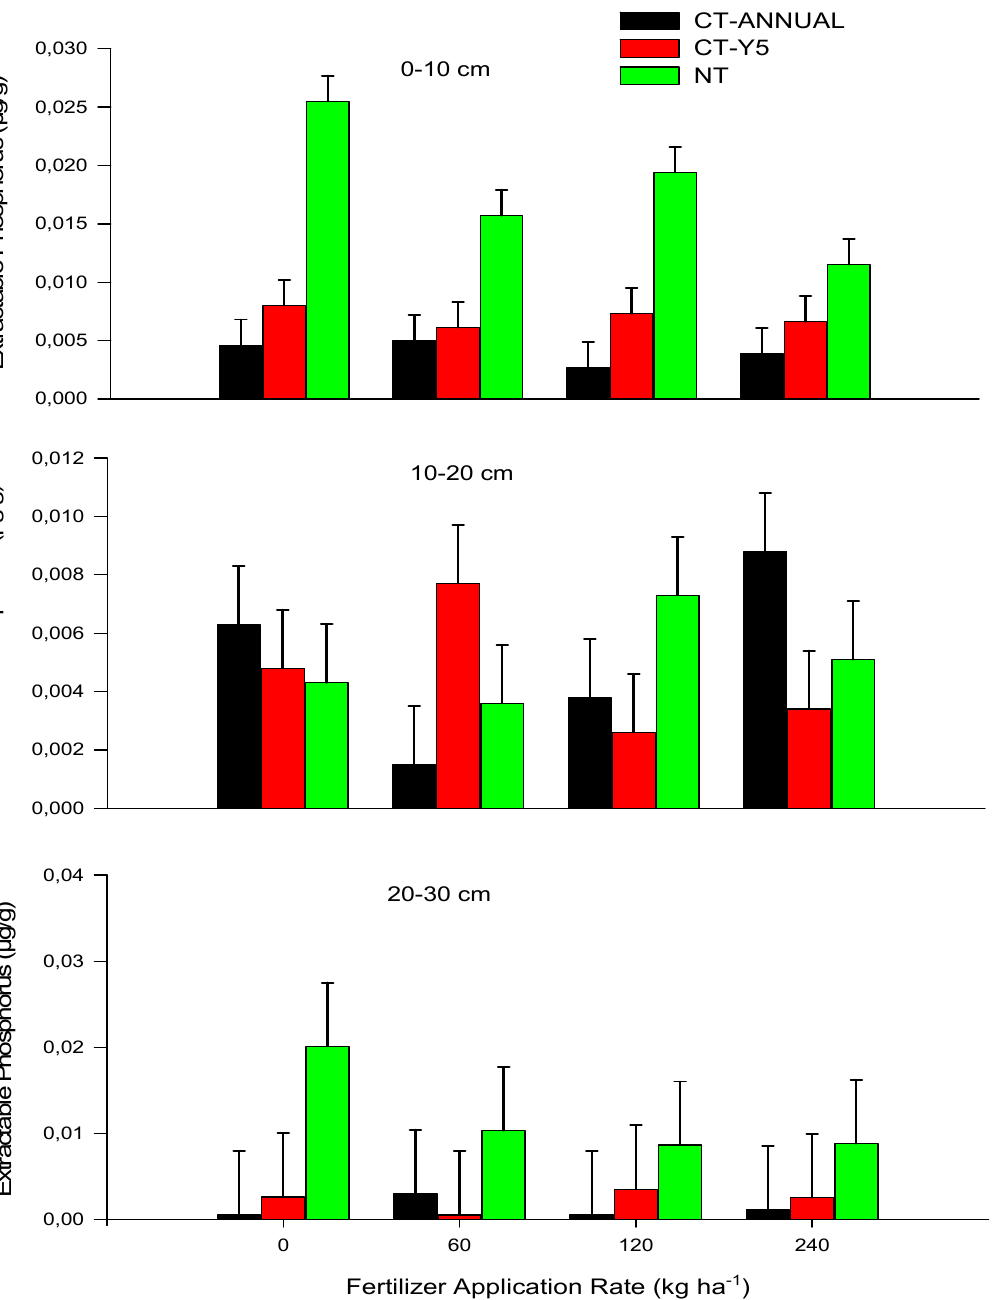
Figure 7. Contents of extractable P according to depth under different tillage techniques and urea fertilizer application rates.